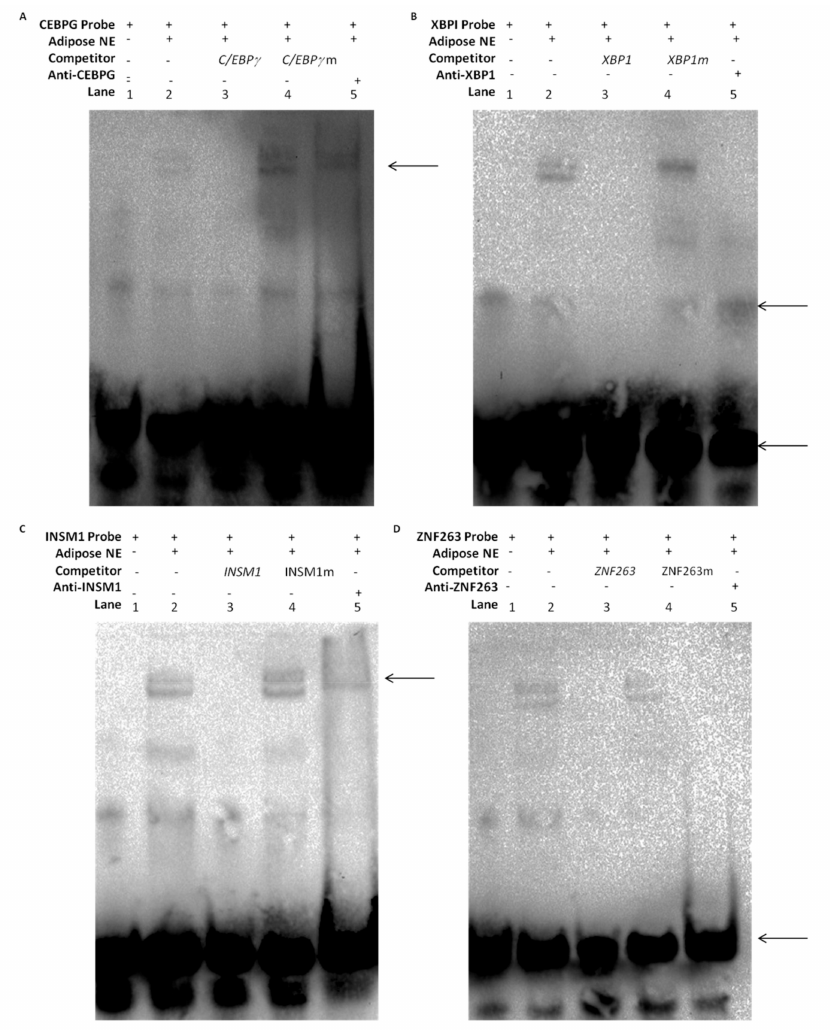
Figure 9. Electrophoretic mobility shift assay (EMSA) shows in vitro DNA-protein interaction of C / EBP γ , XBP1 , INSM1 and ZNF263 transcription factors to the TORC2 promoter. The nuclear protein extracts of bovine preadipocytes were incubated with the C / EBP γ ( A ), XBP1 ( B ), INSM1 and ZNF263 ( D ) free probes (lane 2), 10 × non biotinated probes (lane 3), 10 × mutated probes (lane 4) and the super shift migrated of DNA-Protein with anti-CEBPG, Anti-XBP1, Anti-INSM1 and Anti-ZNF263 antibodies complexes (lane 5) ( A – D ). ( A – C ) the arrow indicates the supershift of the protein-DNA complexes, ( B , D ) and the bottom arrows indicate that the amount of the main complexes was clearly